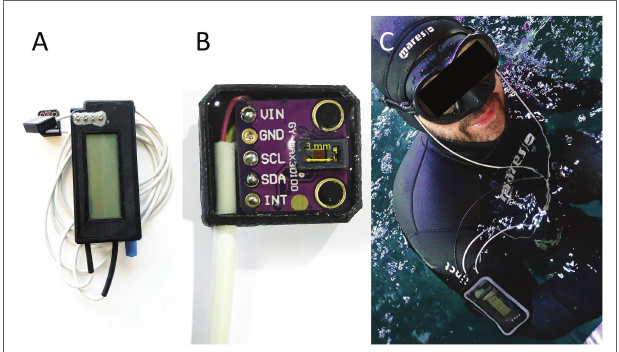
FIGURE 1 | (A) The SUB pulse oximeter; (B) Close of the pulse oximetry sensor, distance between LED and photodiodes (3 mm) is marked with yellow arrow; (C) Freediver in the pool with the two sensor heads on the temples with the data storage unit attached to the